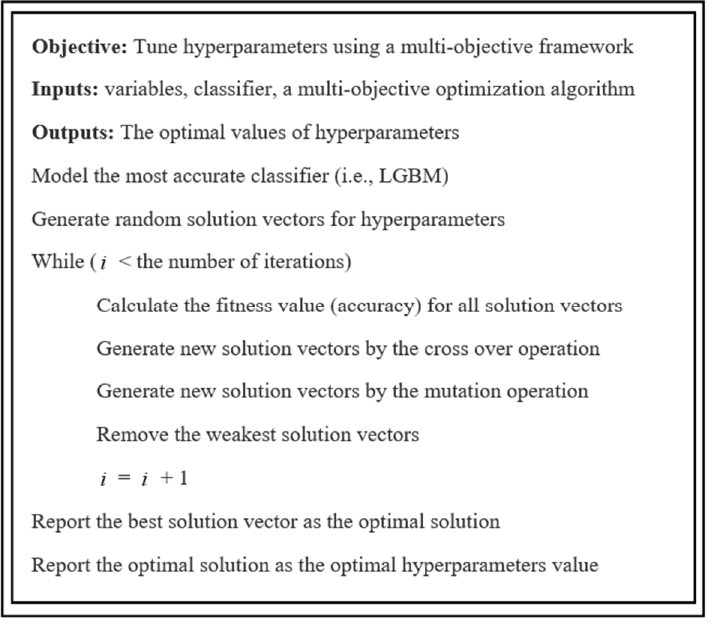
Figure 2. The pseudo-code of MOHT.